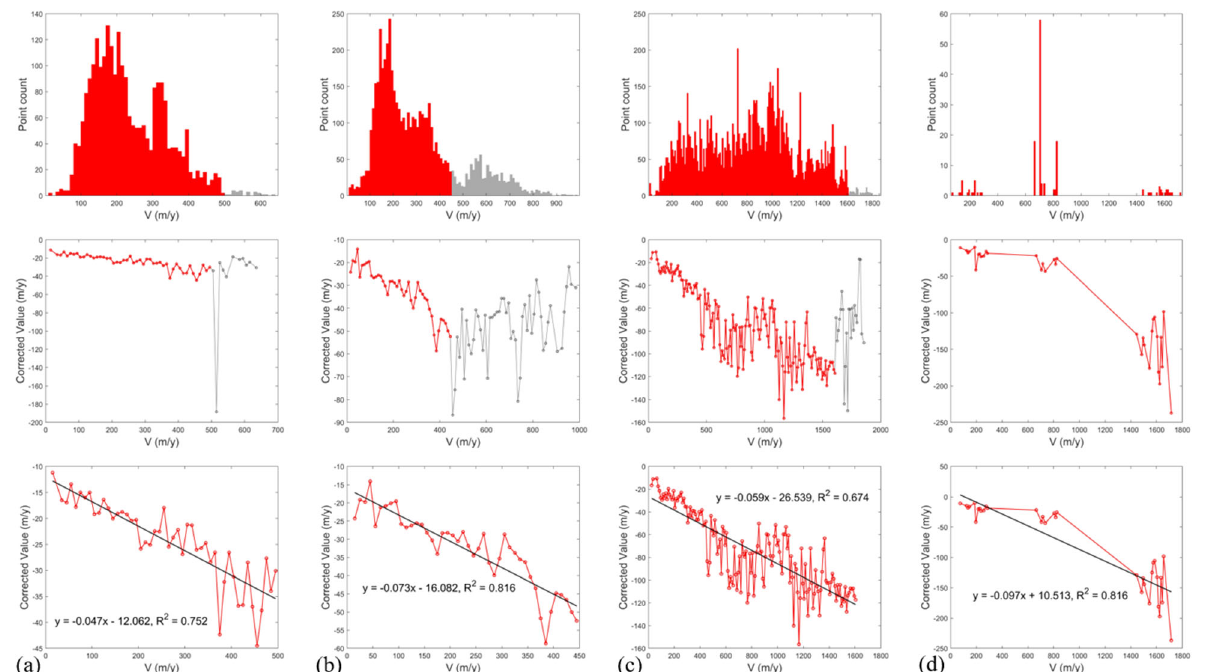
Figure 5 . The relationship between corrected values and V (a) without GL0’25 km buffer and in inland (Sub-region 1), (b) within GL0’25 km buffer and in inland (Sub-region 2), (c) within GL0’25 km buffer and in ice shelf (Sub-region 3), (d) without GL0’25 km buffer and in ice shelf (Sub-region